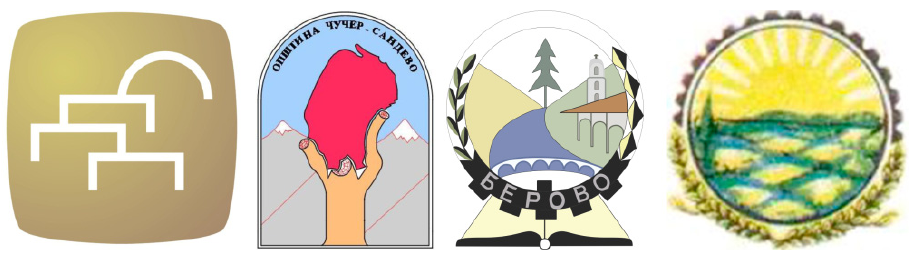
Figure 9. Sample of arms with some heraldic potential.